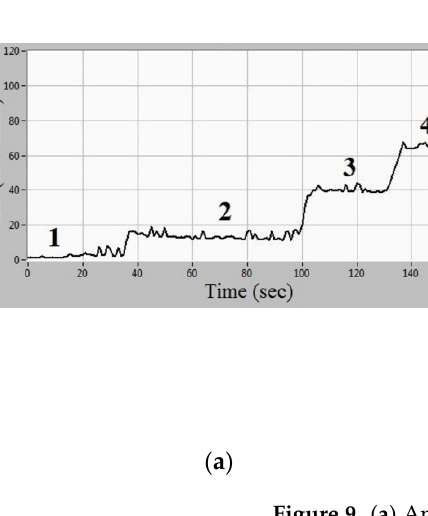
Figure 9. ( a ) An example of BF recorded by an optical probe; ( b ) time intervals 1–4 correspond to periodic electrical signals of different amplitudes supplied from the